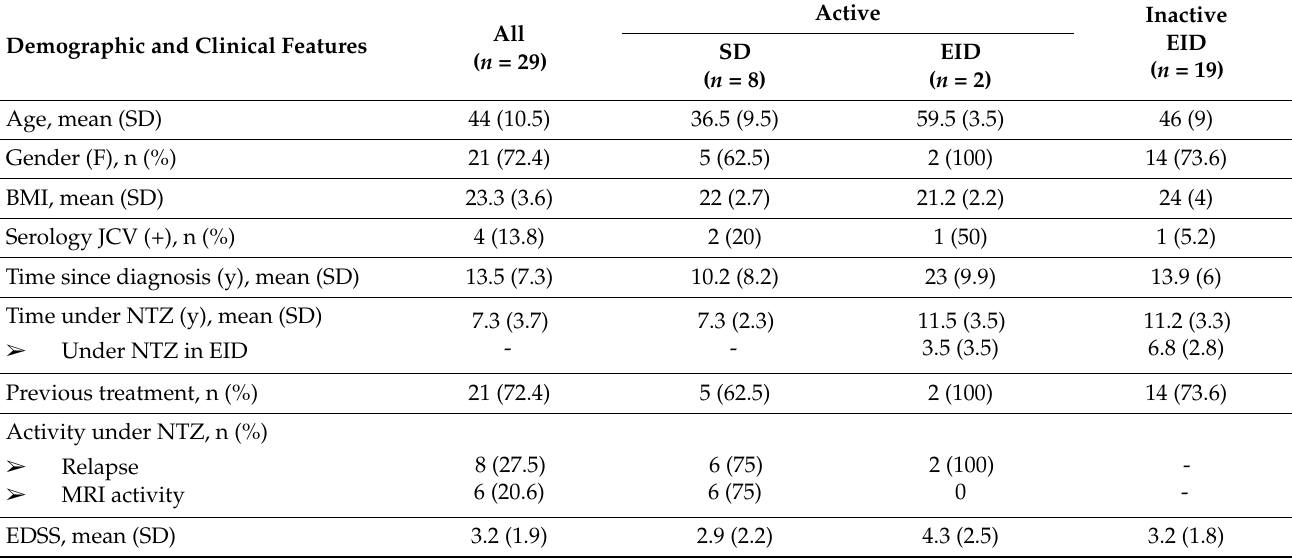
Table 1. Demographic and clinical features of the 29 RRMS patients of the